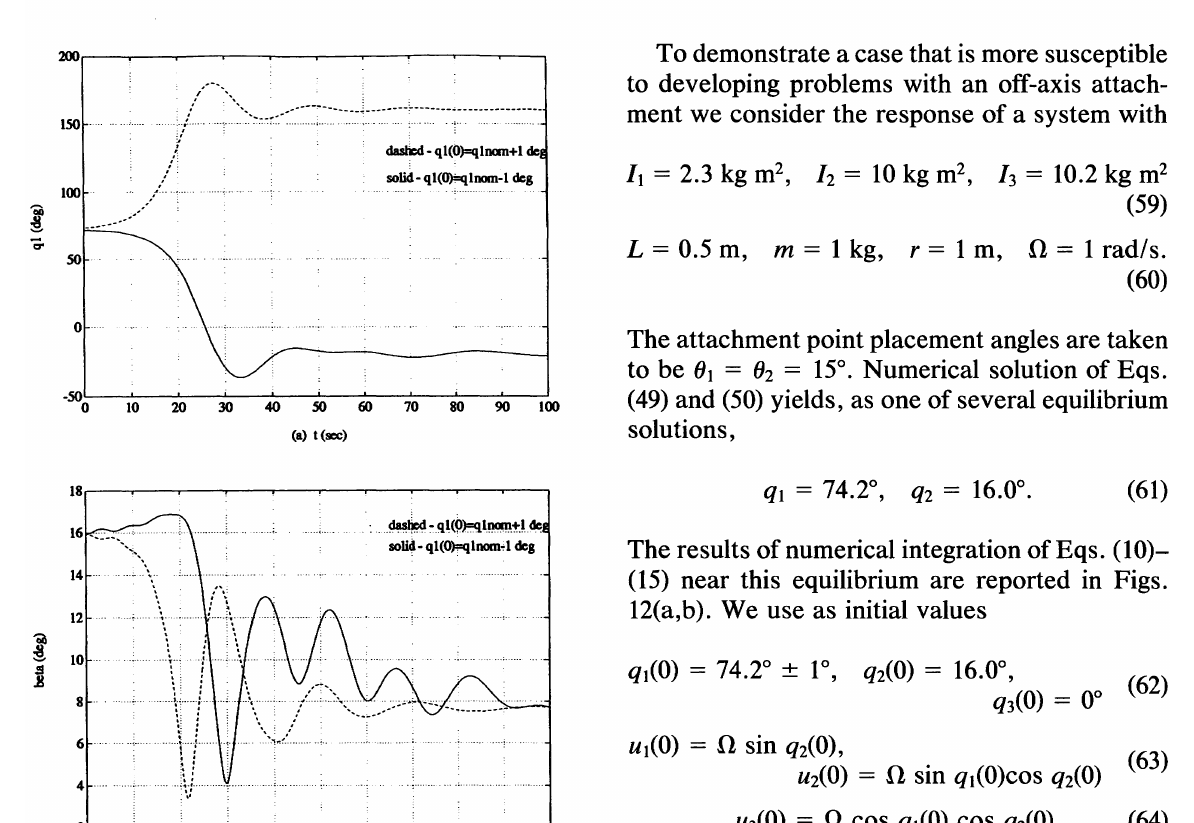
FIGURE 12 Unstable response of a system with off axis attachment. (a) q) (deg), and (b) f3 (deg).